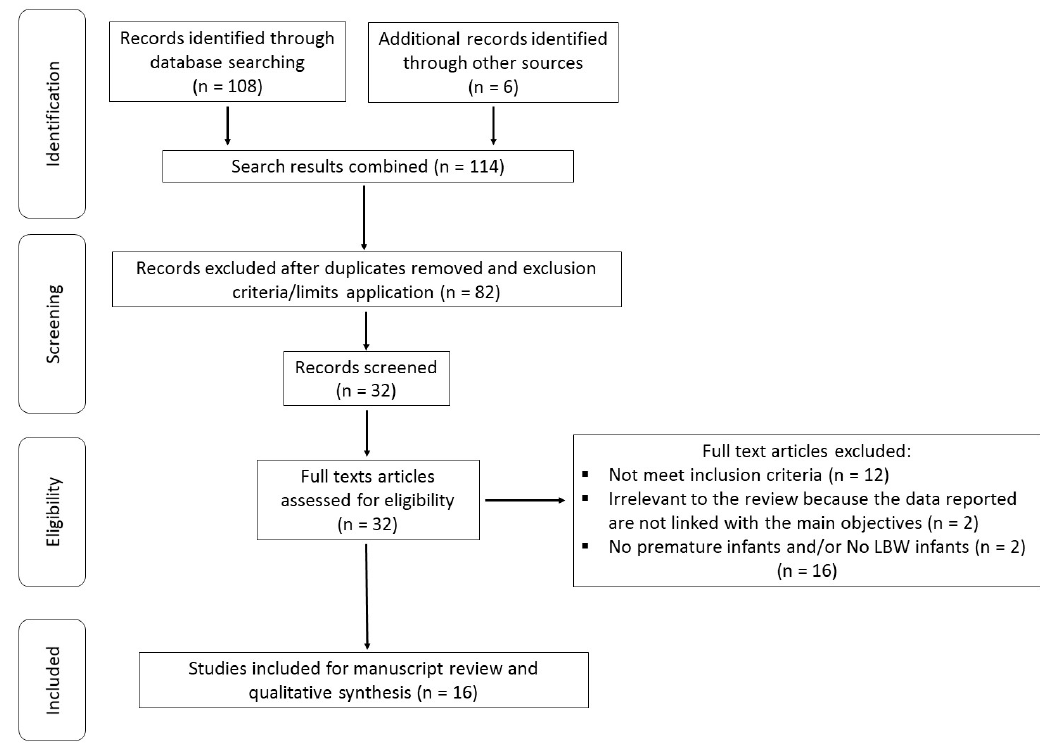
Figure 1. Flowchart showing study selection procedure and results.